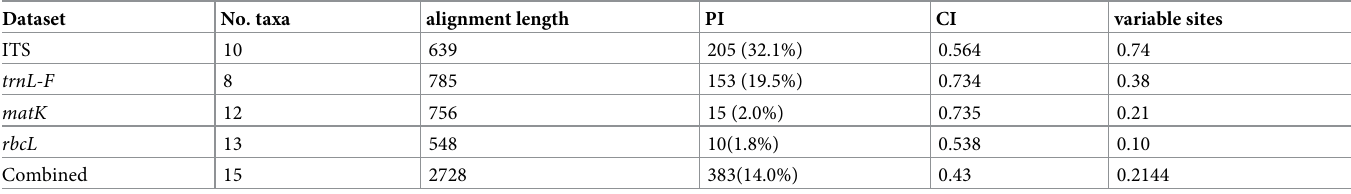
Table 2. Statistical properties of the dataset used for phylogenetic